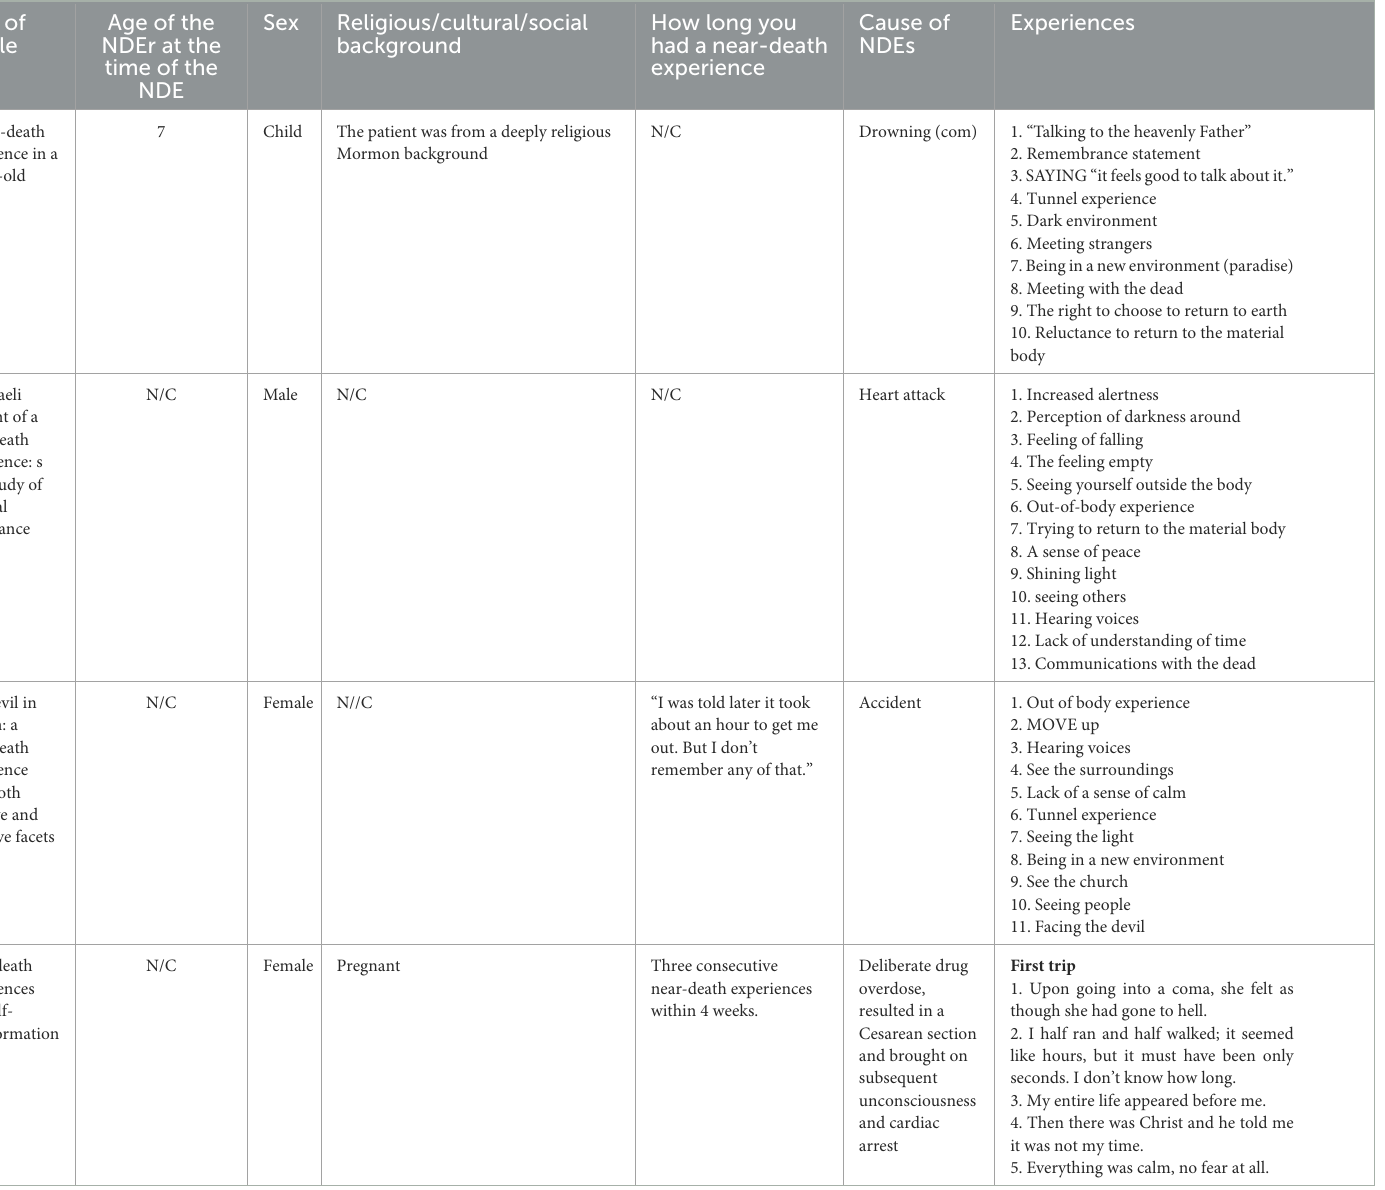
TABLE 2 Characteristics of the case report studies and background detail of near-death experiencers ( N =